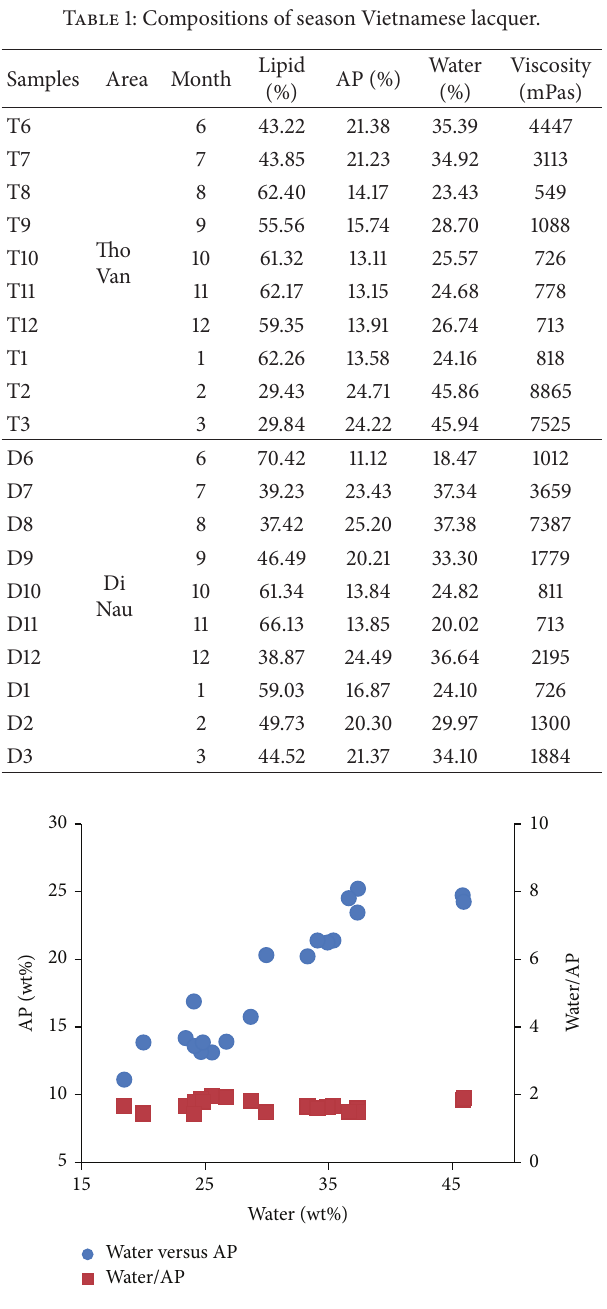
Figure 1: Ratio of water to